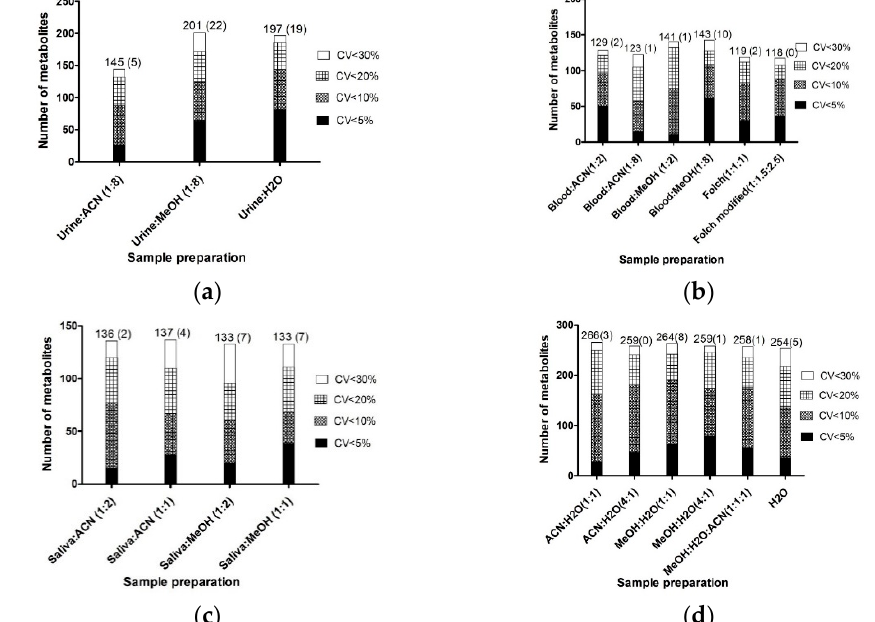
Figure 2. Histogram showing the total number of metabolites extracted for each preparation and their respective reproducibility evaluated by CV (coefficient of variation) in urine ( a ), blood ( b ), saliva ( c ), and feces ( d ). The numbers of metabolites found to be unique from each preparation condition are in brackets.